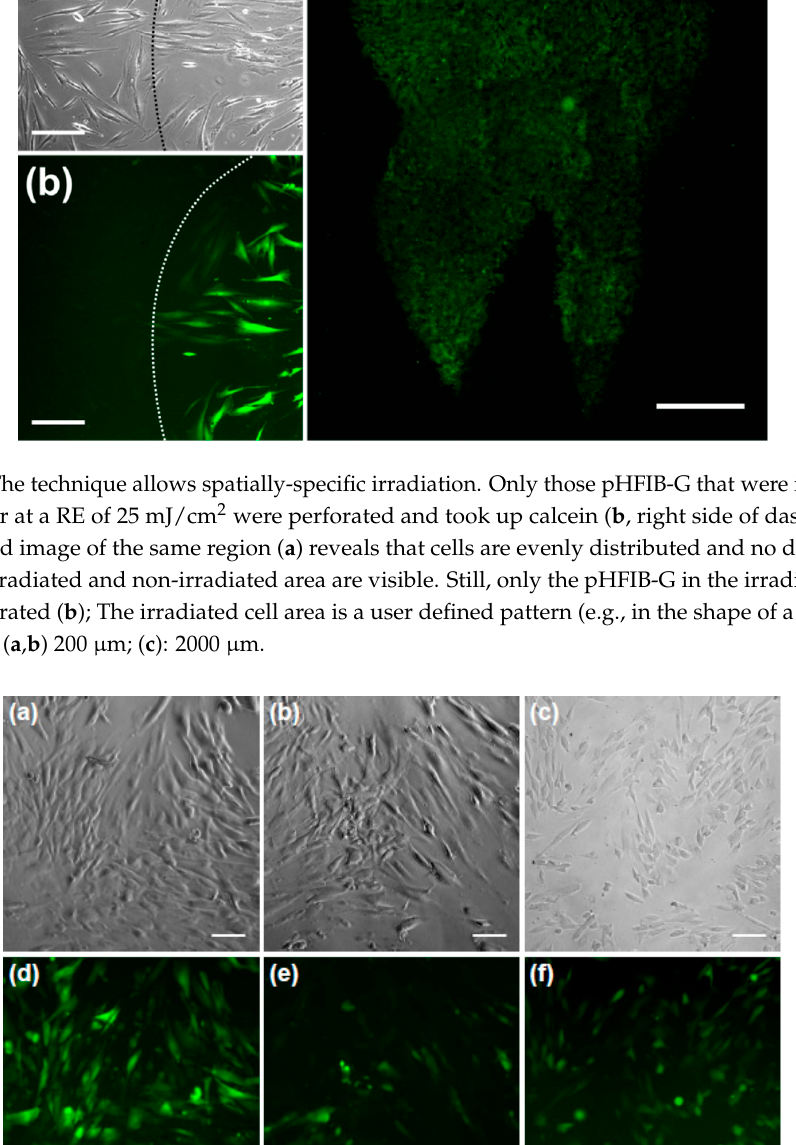
Figure 4. pHFIB-G irradiated with a RE of 25 mJ/cm 2 can also take up molecules larger than calcein. pHFIB-G took up fluorescently labeled dextrans with molecular weights ( d ) 10 kDa; ( e ) 70 kDa; and ( f ) 500 kDa dextrans; as shown in the bright-field images ( a – c ); All scale bars: 35 μ m.